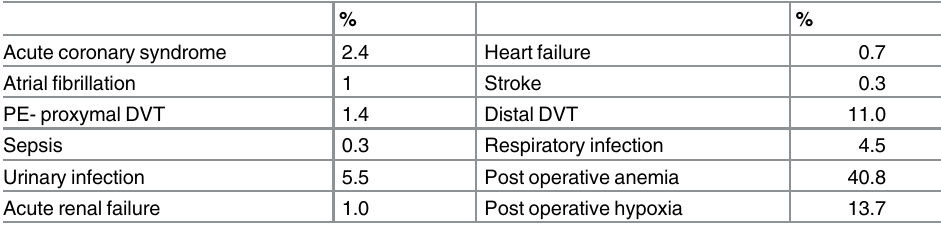
Table 2. In hospital complications during the study period.